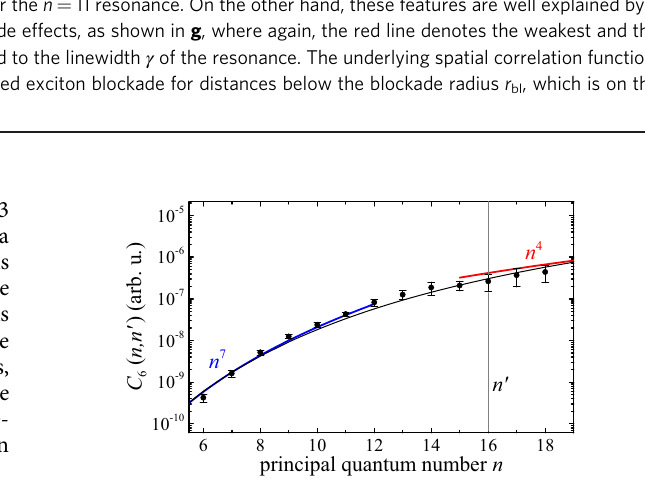
Fig. 2 Observed scaling of the van der Waals coef fi cient. Measured values (black dots) and theoretical prediction following Eq. (3) (black line) for the inter-state van der Waals coef fi cient C 6 ð n ; n 0 Þ , that yields the strength of long-range interactions between excitons with different principal quantum numbers n and n 0 . Here, n 0 ¼ 16 is held fi xed while varying n , whereby the theory curve has been scaled to match the experiment at n = 18. For n (cid:5) n 0 , theory and experiment give a simple~ n 7 scaling (blue), which fl attens in the opposite limit, when approaching the expected ~ n 4 behavior for n (cid:6) n 0 . The error bars denote the standard